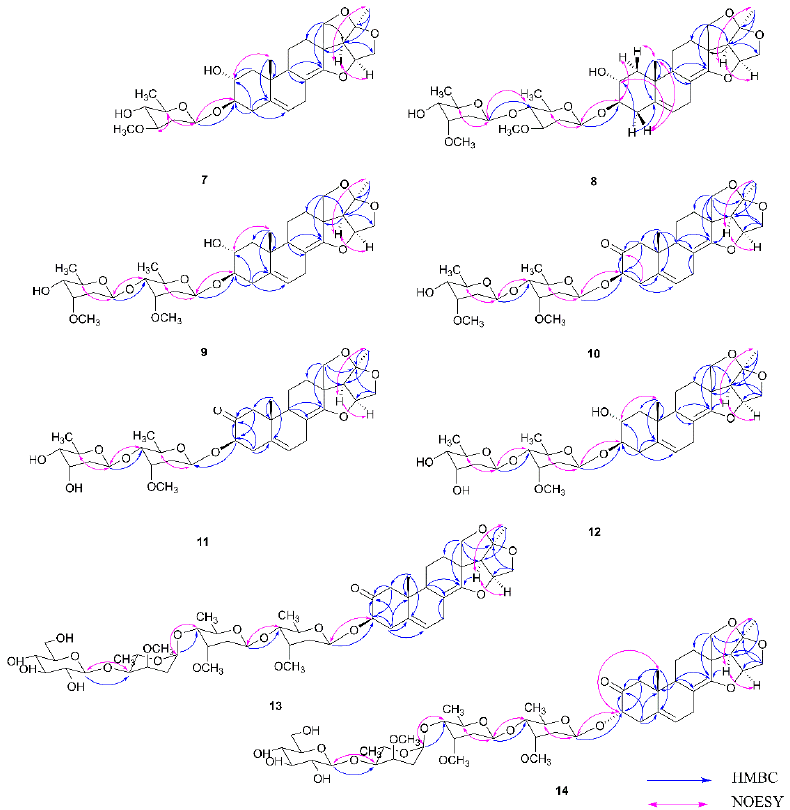
Figure 3. Key HMBC and NOESY correlations of compounds 7 – 14 .